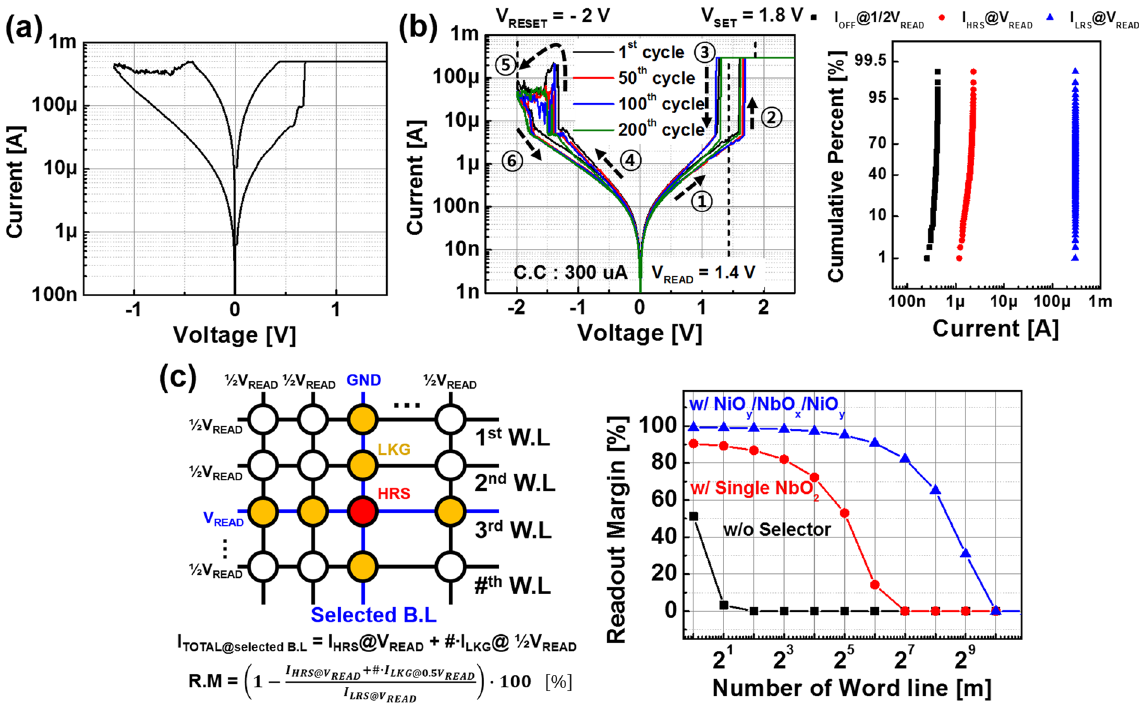
Figure 5. ( a ) DC I-V characteristic of TiN/Ti/HfO x /TiN ReRAM and ( b ) DC I-V characteristic of NiO y /NbO x / NiO y selector device with TiN/Ti/HfO x /TiN ReRAM. ( c ) Readout margin of TiN/Ti/HfO x /TiN ReRAM with single NbO x and NiO y /NbO x /NiO y